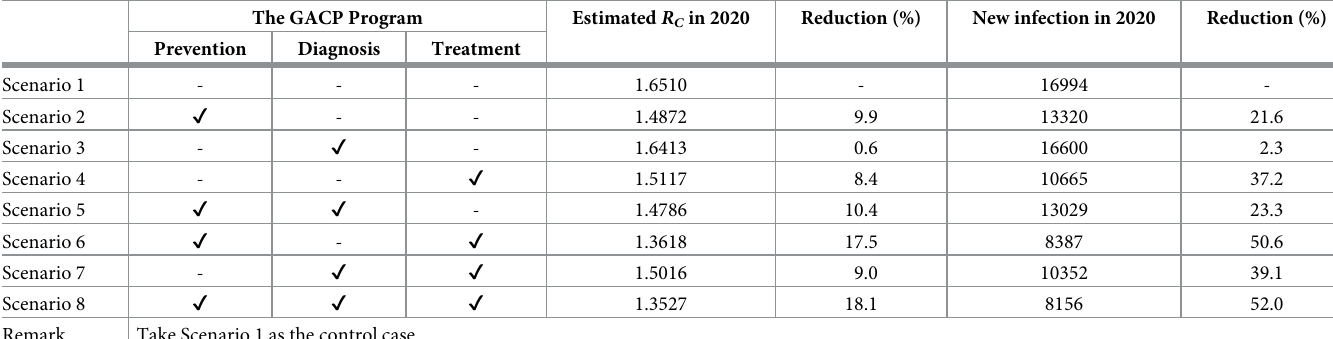
Table 6. List of different implementation